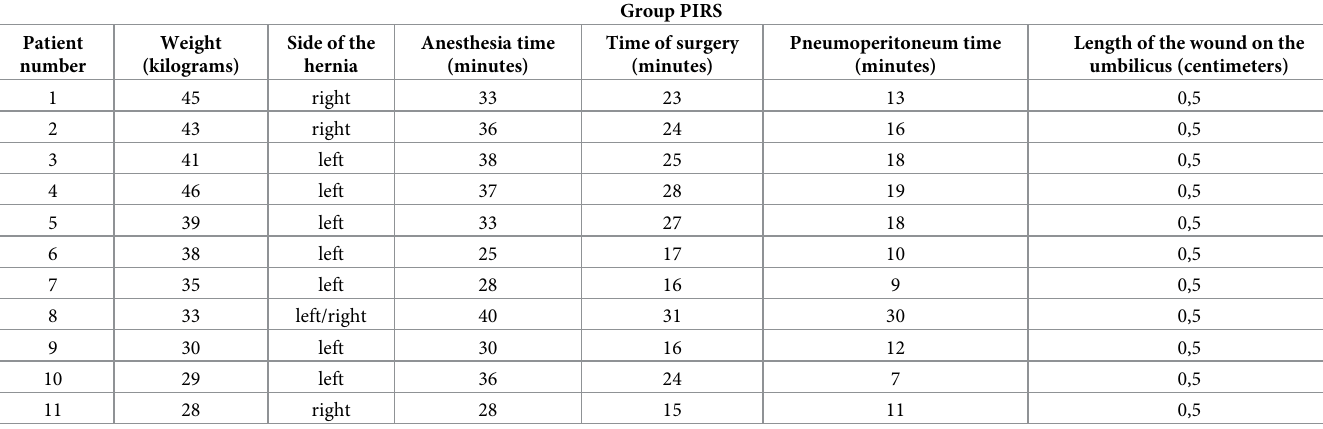
Table 2. Listing and additional information about operated pigs–PIRS